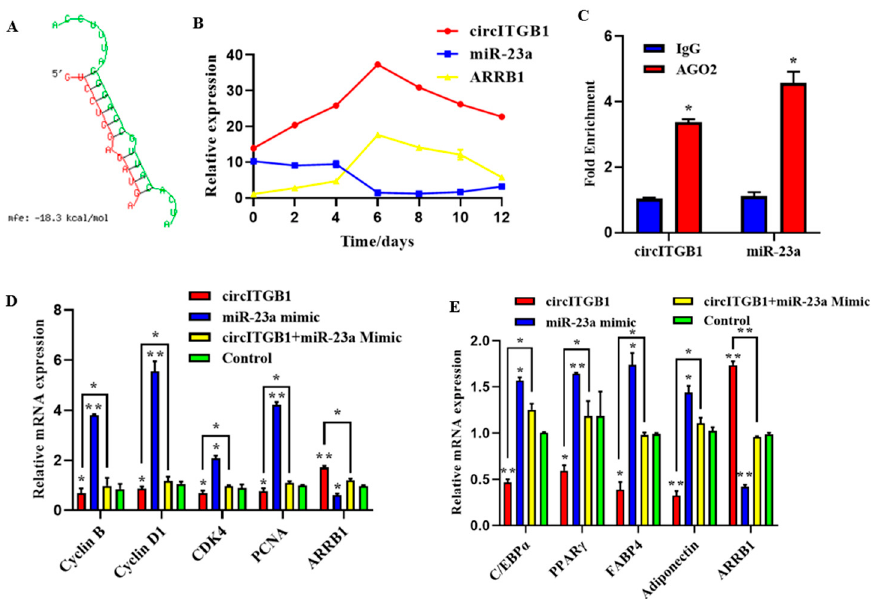
Figure 7. CircITGB1 act as a ceRNA for miR-23a. ( A ) Predicted binding site between circITGB1 and miR-23a. ( B ) Expression trends of circITGB1, miR-23a, and ARRB1 during adipocyte differentiation ( C ) The results of the RNA-binding protein immunoprecipitation experiment were compared with IgG. ( D ) Expression levels of cyclin B, cyclin D1, CDK4, PCNA, and ARRB1 in adipocytes by qPCR. ( E ) Expression levels of C/EBP α , PPAR γ , FABP4, adiponectin, and ARRB1 in adipocyte by qPCR. * p < 0.05, ** p < 0.01.